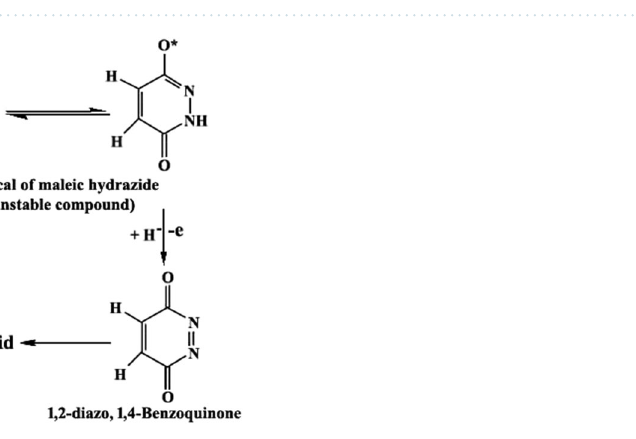
Figure 2. Quality parameters i.e. Loss of Fresh weight, Reducing sugar content, Total phenolic content, Total protein content after storage period of 42 days. “New” denotes the fresh tubers and “Old” denotes the untreated tubers post the storage period of 42 days. The data presented is the mean ± SD. The bars denoted by the same letters "a, b, c" are not significantly different.